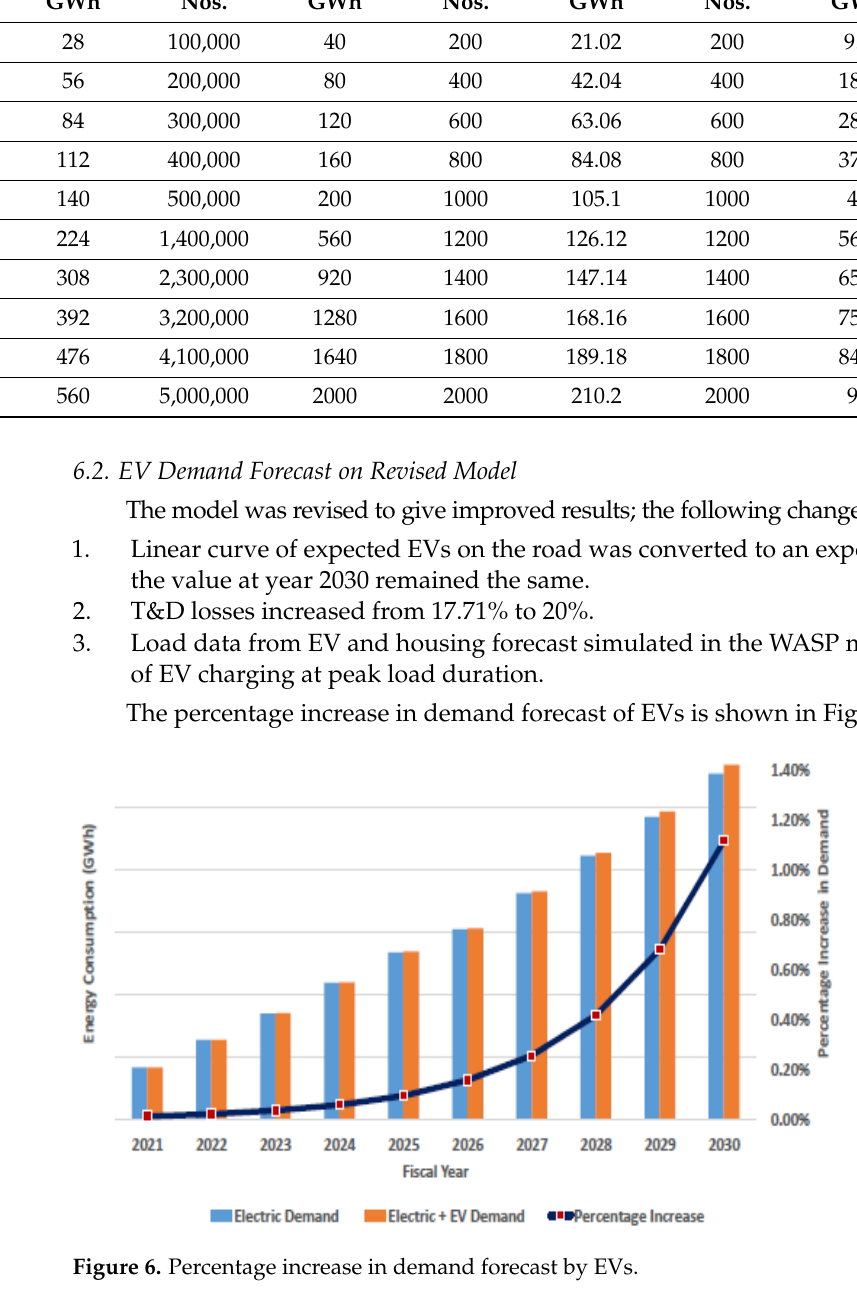
Table 3. EV electricity consumption: 2021 – 2030.